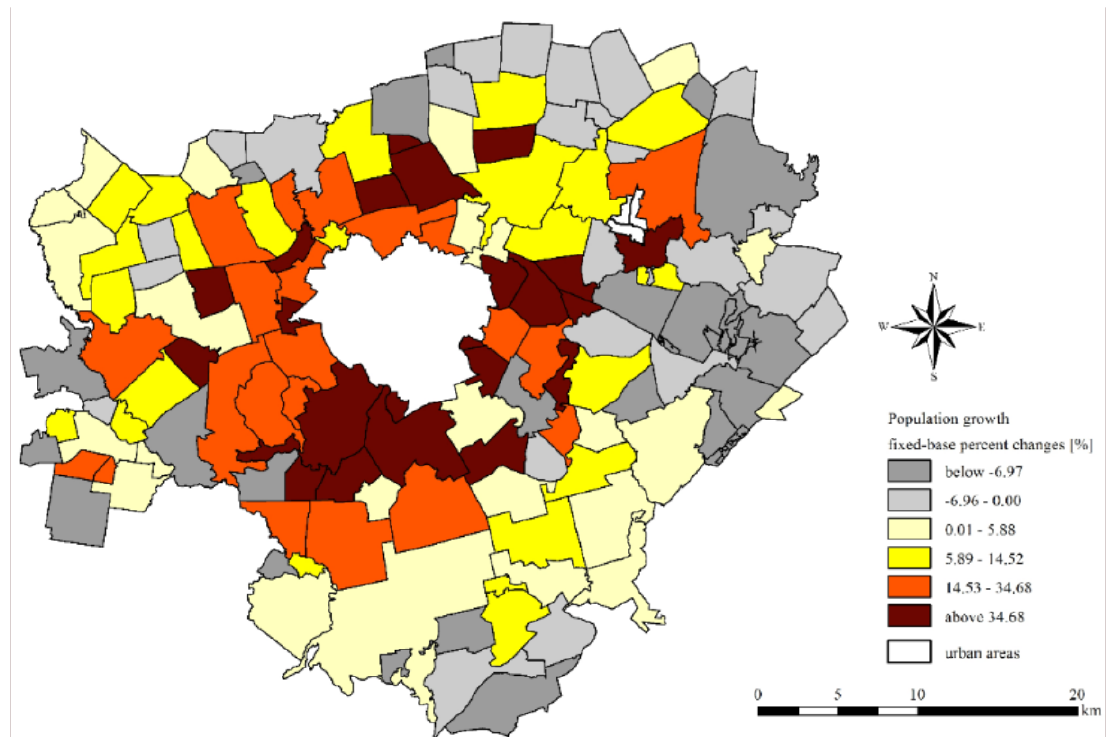
Figure 7. Relative population growth in the Olsztyn FUA in 2007–2018. Source: own elaboration.